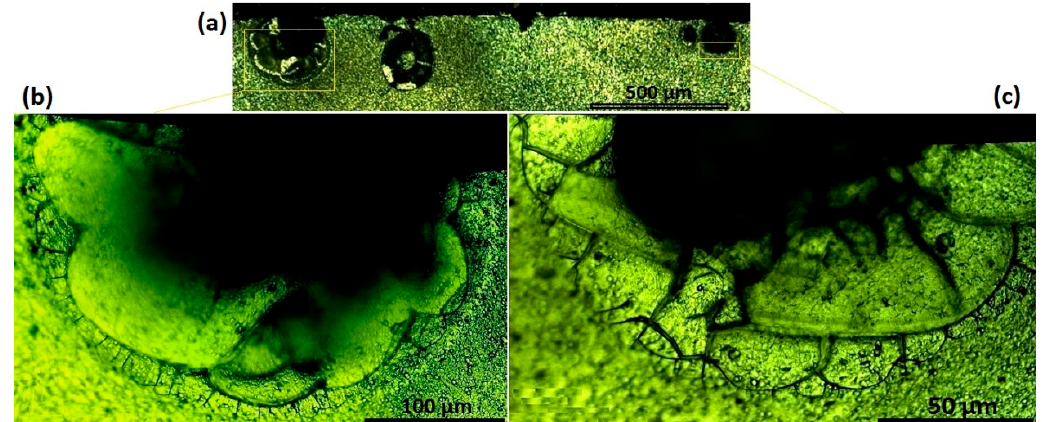
Figure 11. Interface layer between the inclusion defect (external oxide particles) and the parent phase of the weld (S.Z mass). ( a ) Oxide inclusions at the sub-shoulder location of the S.Z. ( b , c ) Enlarged details of yellow rectangles in ( a ) showing the crystalline incoherent-semicoherent interfaces of the oxide inclusions with the S.Z lattice. All images processed by etchant I.